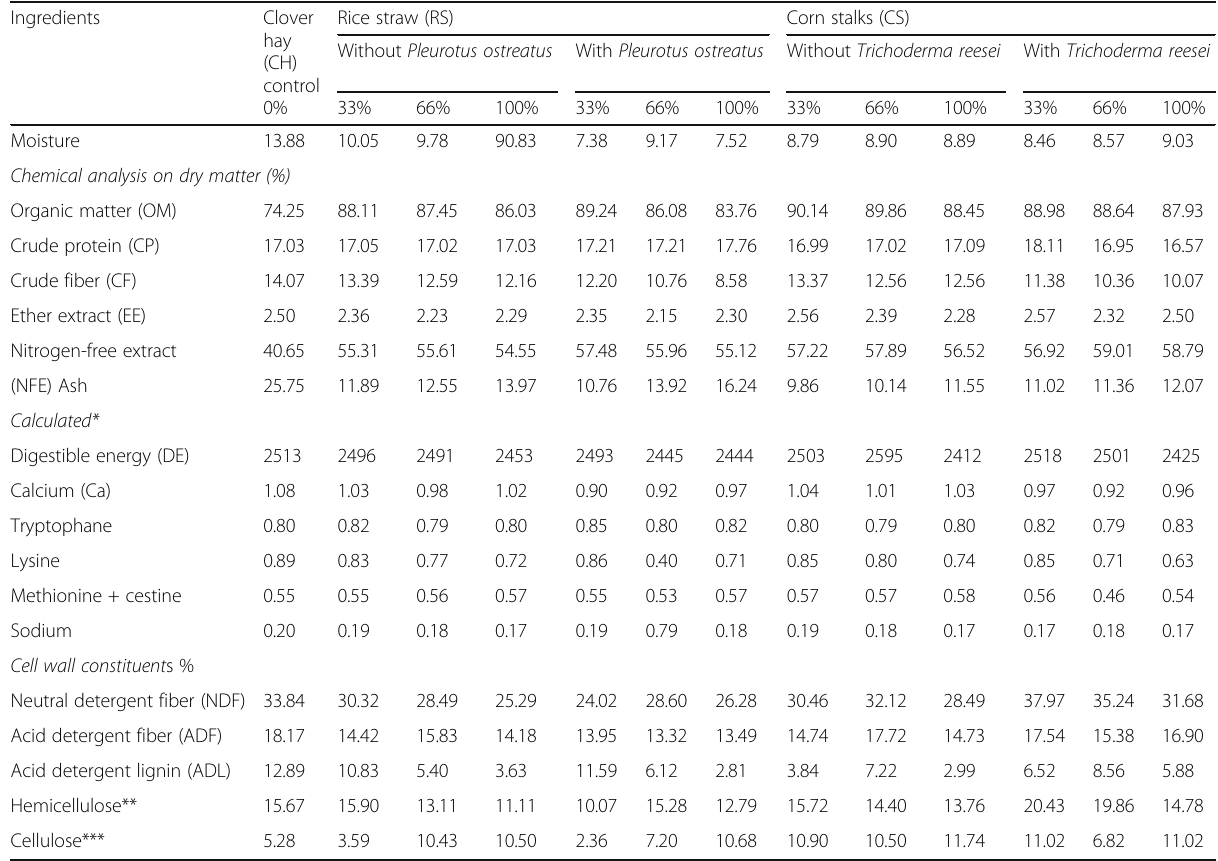
Table 3 Chemical analysis of the experimental rations Ingredients Clover